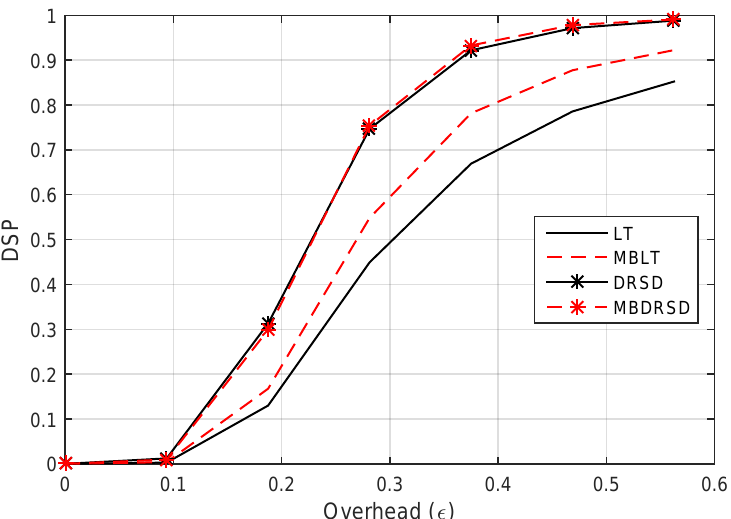
Figure 8. DSP versus the overhead ( (cid:101) ) for different coding schemes at k = 128 and erasure probabili- ties of ε 1 = 0.01, ε 2 = 0.01, and ε 3 =